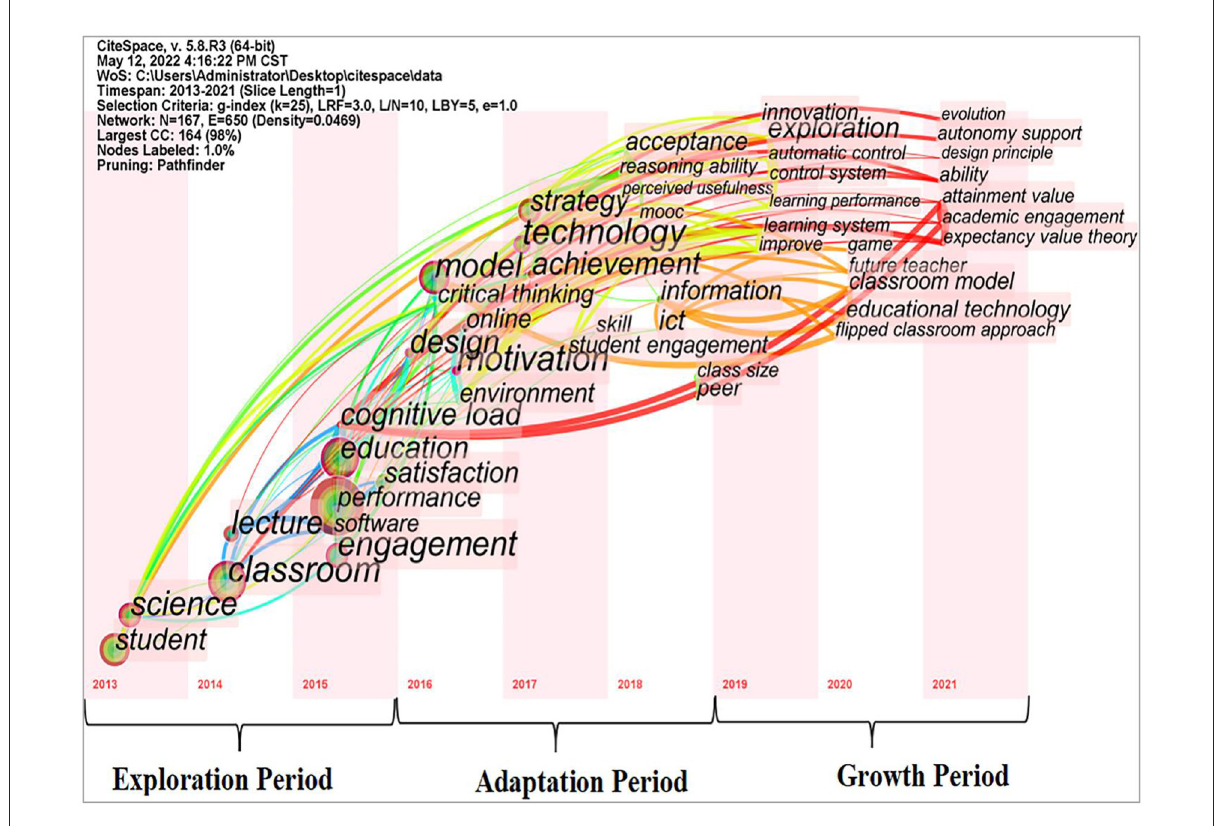
FIGURE8 Keywords time zone